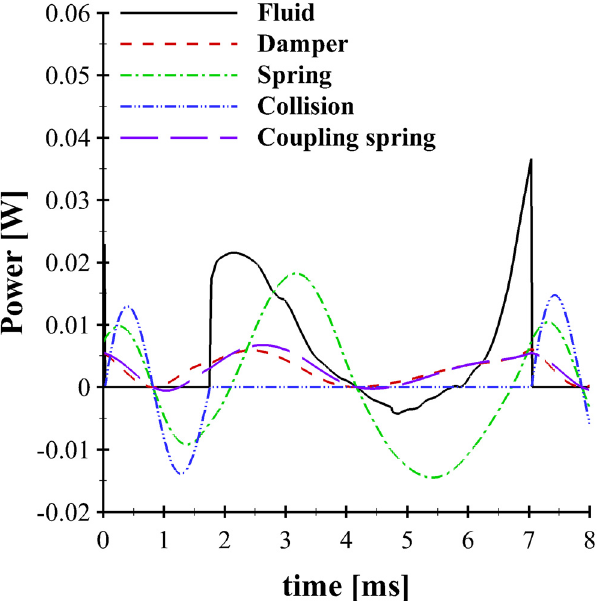
Fig 6. Vocal Fold energy exchange using the BLAST (Case 5) solver. Transfer of energy between the components of mass 1 of the left VF, including the fluid (-), damper (- -), spring (- . -), collision force (- . . -) and coupling spring (– –). The subglottal pressure and symmetry parameter were p = 1.0 kPa and Z = 1.0, s